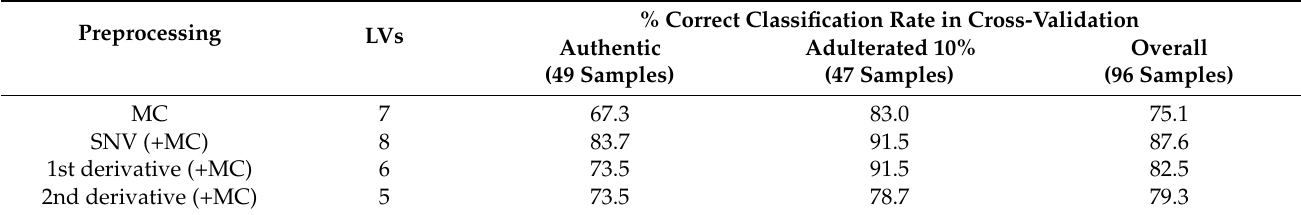
Table 2. PLS-DA classification of authentic vs. 10% adulterated samples: results of cross-validation for model selection.